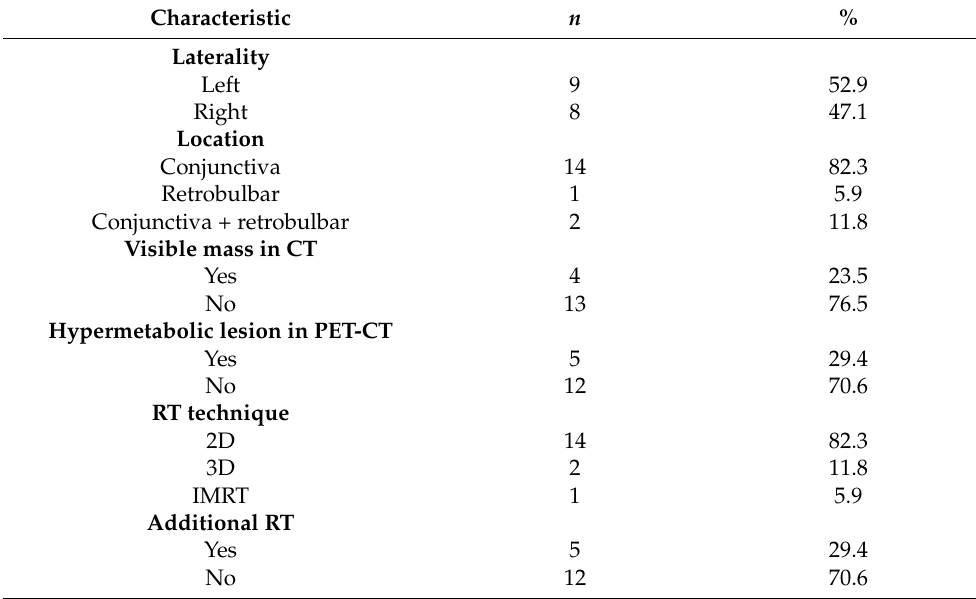
Table 2. Baseline characteristics of the enrolled eyes ( n = 17).